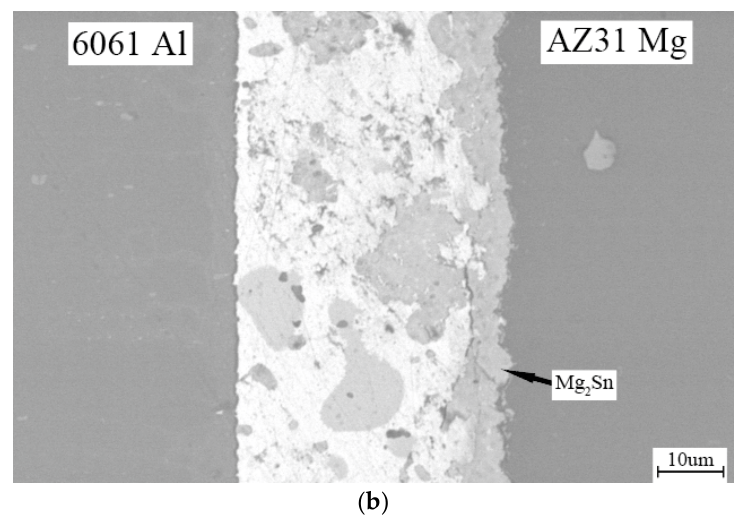
Figure 12. Cross-sectional SEM micrographs of the AZ31 magnesium/6061 aluminum alloy joints bonded with the Sn-30Zn-0.1RE filler metal after aging at 150 °C for ( a ) 50 h; ( b ) 100 h.